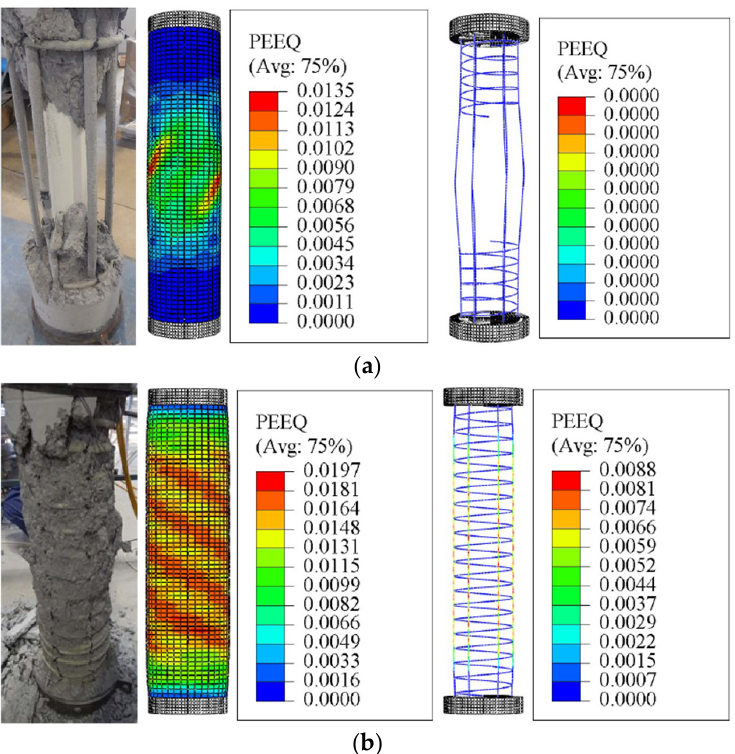
Figure 9. Experimental and finite element (FE) failure patterns of specimens ( a ) C26.8-H00-6#5-90; ( b ) C26.8-H50-6#5-90: Considering the effect of varying amounts of GFRP confinement. Note: PEEQ = Equivalent plastic strain.